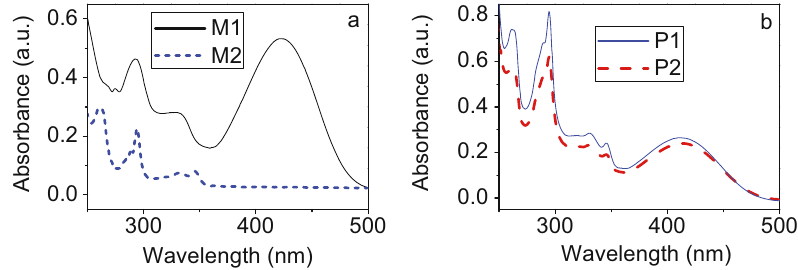
Figure 4: UV - vis absorption spectra of monomers ( a ) and polymers ( b ) in THF.